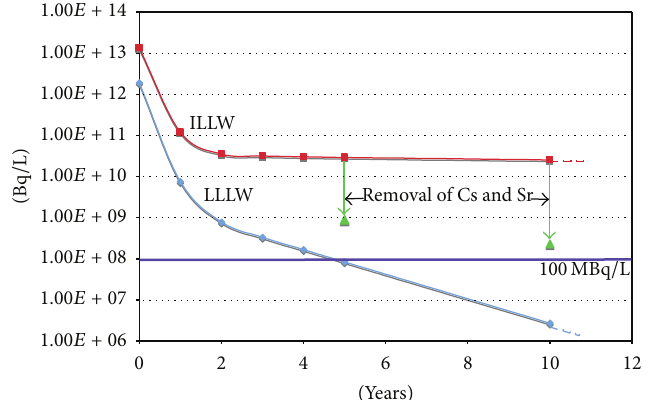
Figure 1: Typical calculated activity in Bq/L of the two liquid wastes from 99 Mo as a function of postproduction time. The intersections of the triangles represent the activity of ILLW if all Cs/Sr is removed after 5 and 10 years of storage, showing the 137 Cs and 90 Sr dominate the ILLW